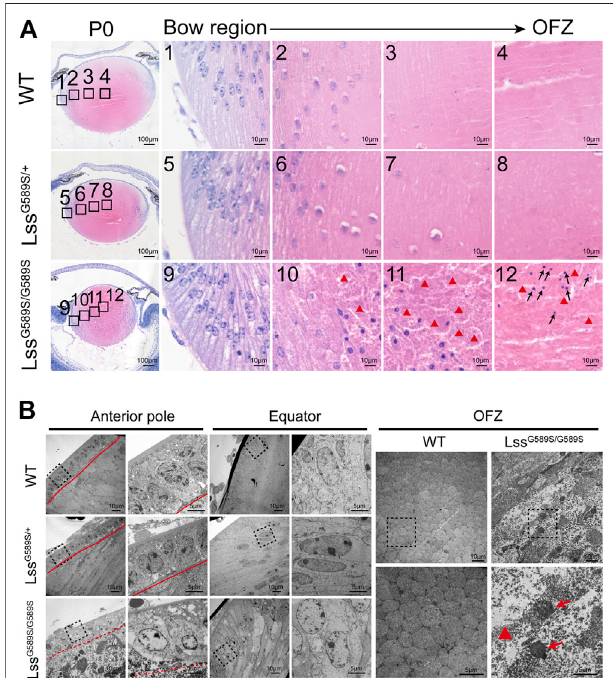
FIGURE 2 | Disrupted lens structure caused by a homozygous Lss G589S mutation at P0. (A) Representative hematoxylin and eosin staining images of lens structure in WT, Lss G589S/+ , and Lss G589S/G589S mice at P0. Boxes of numbers 1 – 4, 5-8, and 9 – 12 indicate four continuous and comparable zones from the lens equator to OFZ within the lens fi ber cell regions of WT, Lss G589S/+ , and Lss G589S/G589S , respectively (the leftmost panel, black boxes). Scale bar: 100 μ m. The enlargements are the magni fi cations of the boxed inset shown in the left panel (numbers 1 – 4, 5 – 8, and 9 – 12). Scale bar: 10 μ m. Red triangles indicate debris and bulks of fi bers in Lss G589S/G589S mouse lens. Black arrows indicate that a large number of fi ber cell nuclei were still retained at the OFZ region of Lss G589S/G589S mouse lens. (B) Electron micrographs of lens morphology at the anterior pole, equator, and OFZ regions in WT, Lss G589S/+ , and Lss G589S/G589S mice. n (cid:1) 4 lensespergroup.Attheanteriorpoleregion,representativeimagesofthelens epithelial – fi ber interface (EFI) were shown. Red solid lines indicate lens epithelial – fi ber interface (EFI) in WT and Lss G589S/+ mice. Red dashed line indicates lens EFI in Lss G589S/G589S mice. Boxes indicate morphology of lens epithelial cells and EFI in WT, Lss G589S/+ , and Lss G589S/G589S mice (left panel) . Scale bar: 10 μ m. The enlargement is the magni fi cation of the boxed inset shown in the left panel. Scale bar: 5 μ m. At the equator region, representative images of alignment and morphology of secondary fi ber cells were shown. Boxes indicate the morphology of secondary fi ber cells (left panel) . Scale bar: 10 μ m. The enlargement is the magni fi cation of the boxed inset shown in the left panel. Scale bar: 5 μ m. At the OFZ region, representativeimagesofalignmentandmorphologyof fi bercellswereshown. Scale bar: 10 μ m. The enlargement is the magni fi cation of the boxed inset shown in the upper panel. Red triangle indicates high-density deposits of fi ber debris, and red arrows indicate condensed nuclei in the central OFZ of Lss G589S/G589S lens. Scale bar: 5 μ